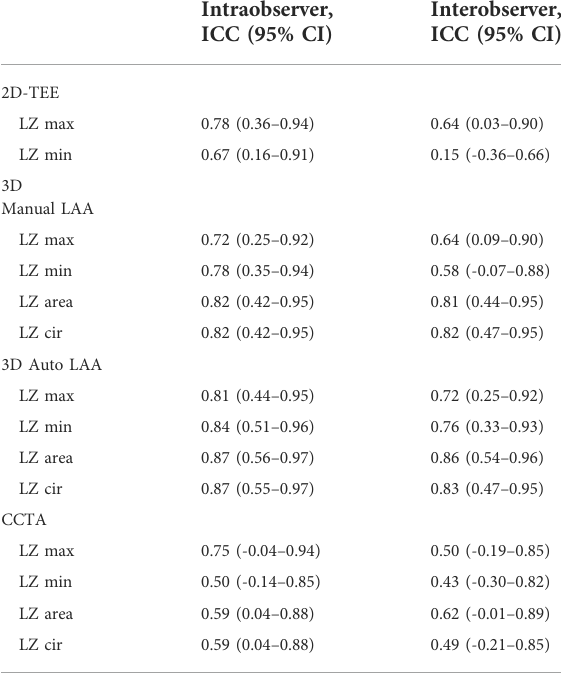
TABLE 3 Intra- and interobserver variability of 2D-TEE, 3D Manual LAA, 3D Auto LAA and